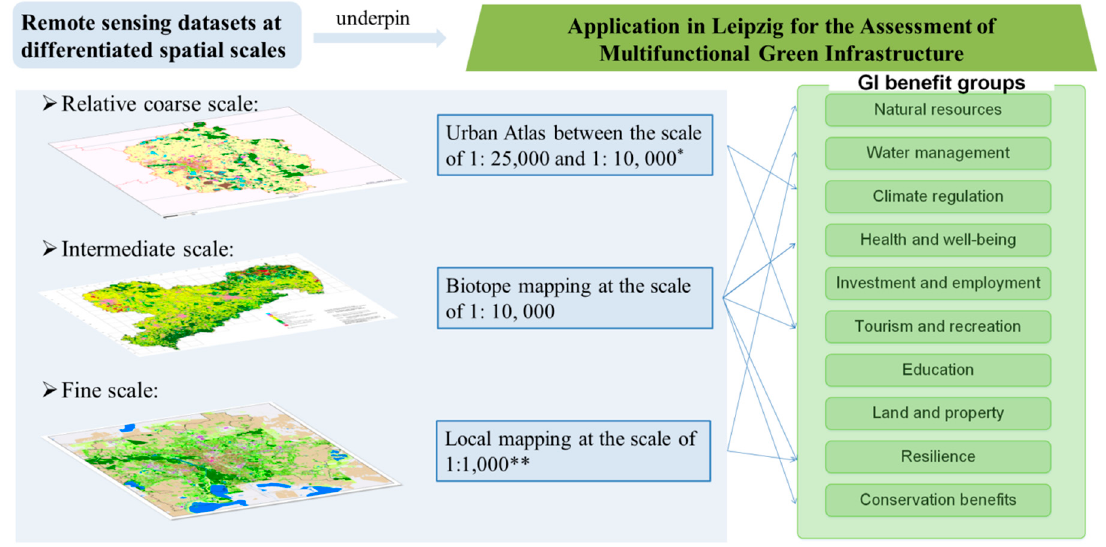
Figure 3. Remote sensing datasets from relative coarse, intermediate, to fine scale as supportive tools for the AMGI in Leipzig.